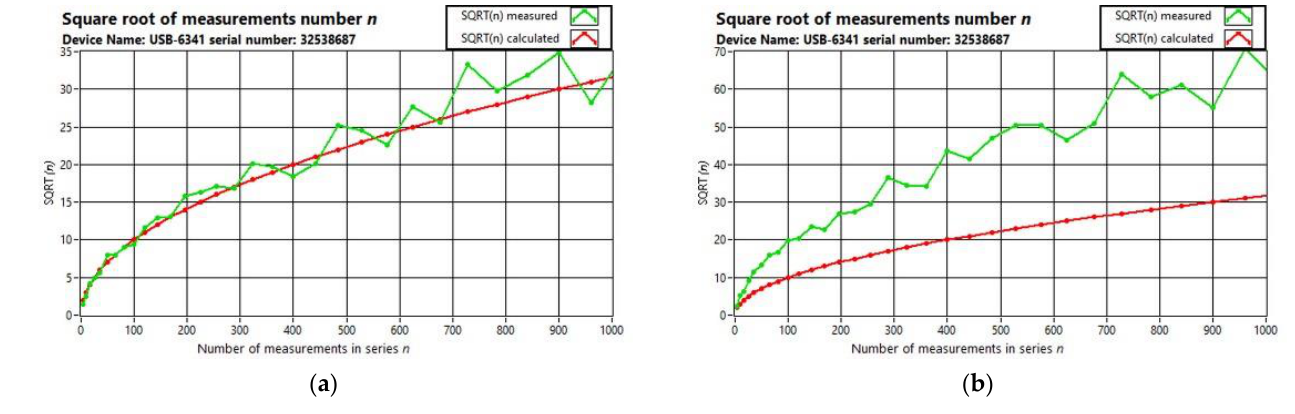
Figure 16. The ratio of the experimental standard deviation in a single result in a series to the